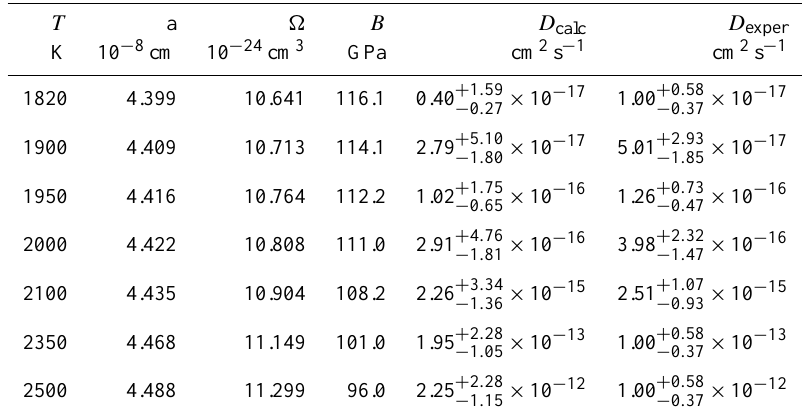
Table 2. The values a, (cid:127) , B , calculated ( D calc ) and experimental ( D exper ) diffusion coefficients along with their errors for the temperature range (1820–2500) K and for c mean act = 0.7422.